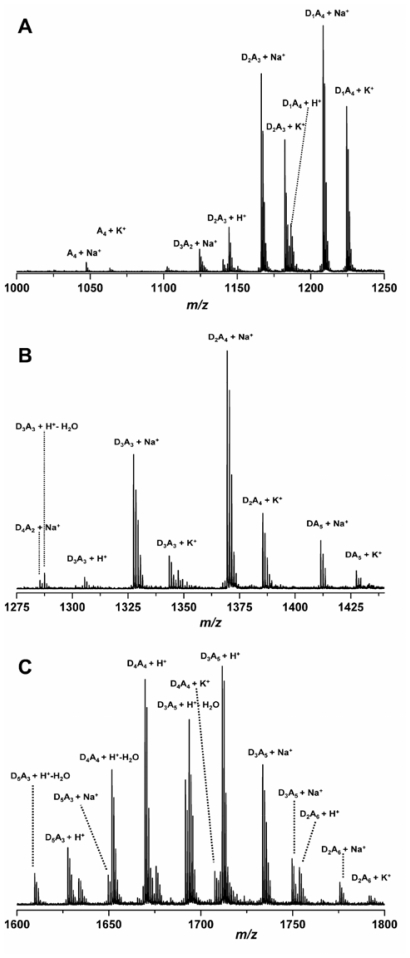
MALDI-TOF-MS of AMAC derivatized chitooligosaccharides: (A) DP 5, (B) DP 6, (C) DP 8. Reprinted from Carbohydrate Polymers 74, 2008, Cederkvist, F.H., Parmer, M.P., Vårum, K.M., Eijsink, V.G.H., Sørlie, M., Inhibition of a family 18 chitinase by chitooligosacharides, 41–49, Copyright (2010), with permission from Elsevier [229].